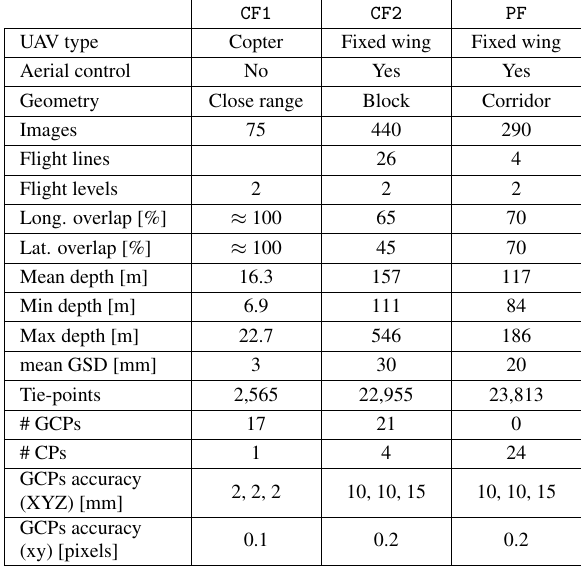
Table 1. Calibration and production flights